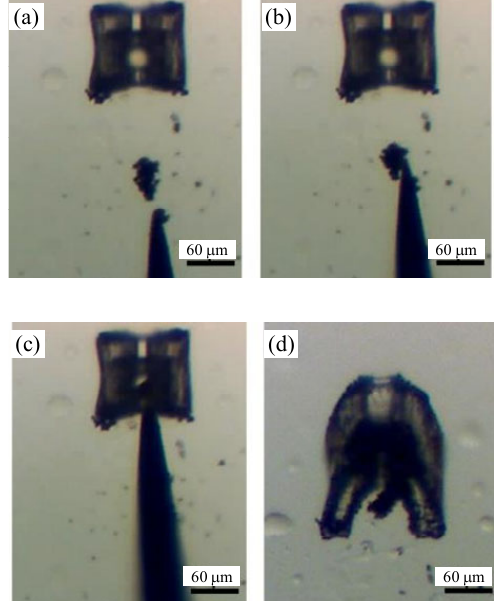
Fig. 5 Flow chart of fluorescent powder and “arch bridge” shaped microstructure micro-assembly: (a) placing the fluorescent powder in front of the “arch bridge” shaped microstructure with an unheated probe, (b) heating the probe to 400 ℃ and moving the fluorescent powder, (c) the fluorescent powder is assembled into the microstructure on a 2D plane with the heated probe, and (d) the assembled microstructure is tilted at an angle of 30°, and the fluorescent powder is placed in the center of the